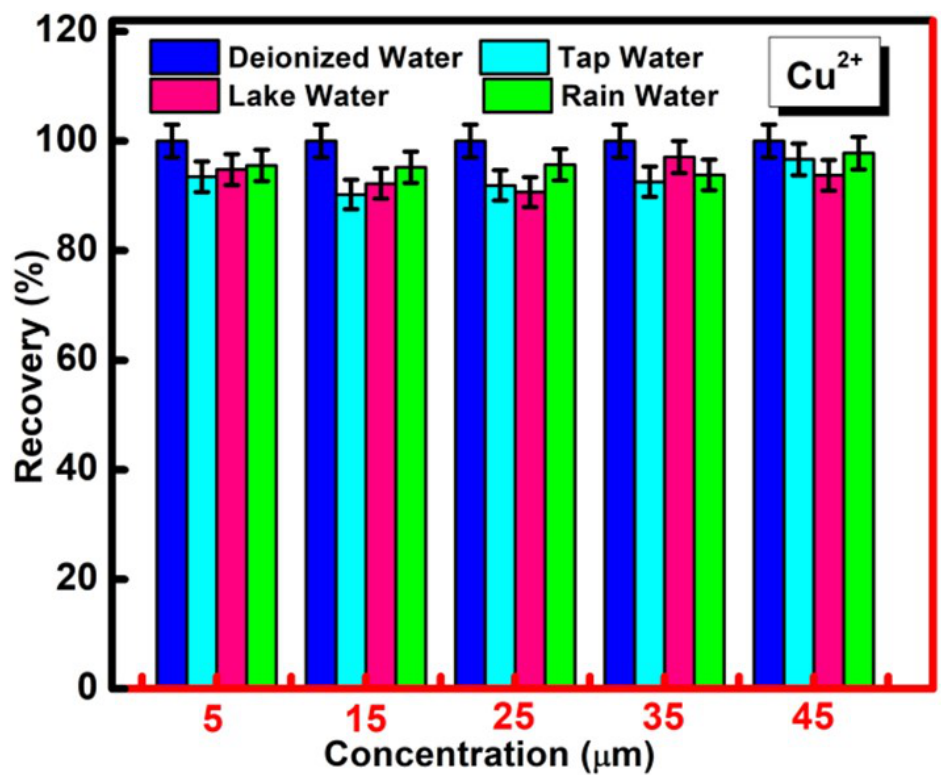
Figure 9. Percentage recovery of CQDs in the presence of different concentrations of Cu 2+ in spiked samples of four different real water sources including tap water, rainwater, lake water and deionized water.